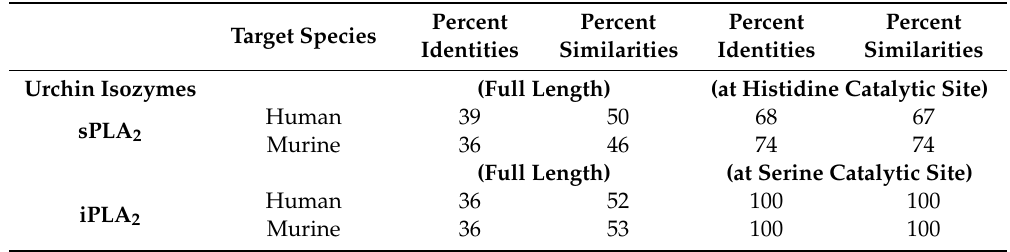
Table 1. Identity and similarity of urchin PLA 2 isozymes to the human and murine